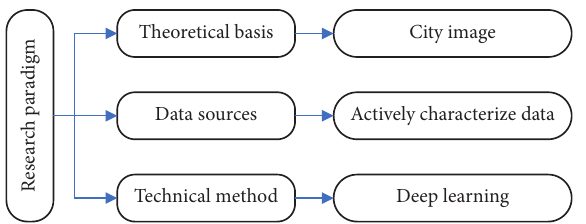
Figure 1: The research paradigm construction of the cognitive model of city